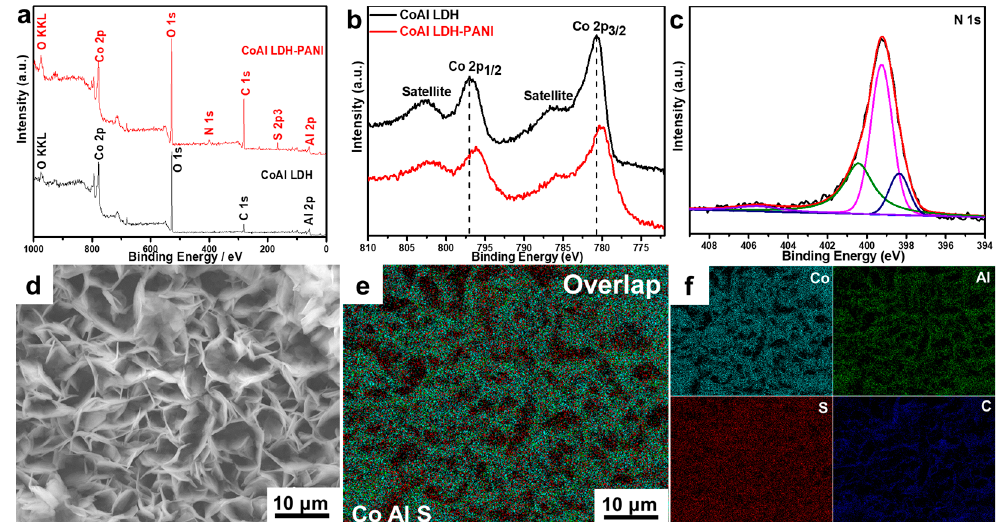
Figure 5. ( a ) The XPS full spectra and ( b ) Co 2p spectra of CoAl LDH and CoAl LDH-PANI. ( c ) N 1s spectrum of CoAl LDH-PANI. ( d – f ) FESEM image of CoAl LDH-PANI corresponding to the EDX elemental mapping images of Co, Al, S, and C showing uniform distribution of the elements.